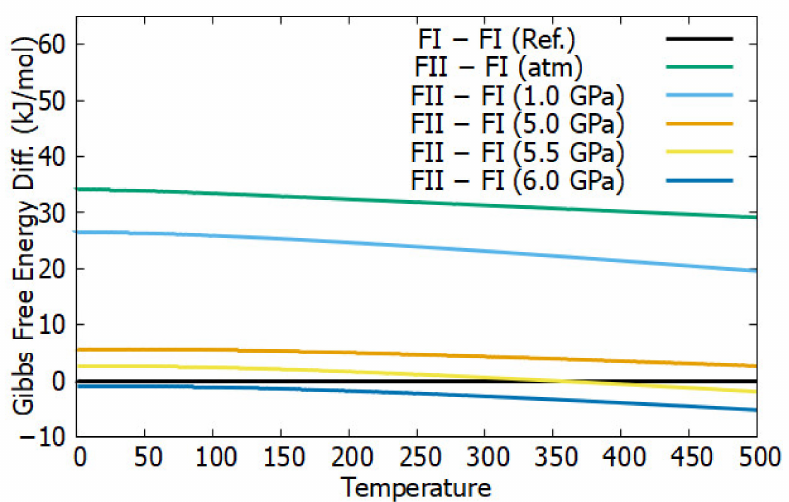
Figure 3. Gibbs free energy differences as a function of temperature for forms I and II. The green, sky-blue, orange, yellow, and blue curves represent pressures of 0.0001 GPa (atmospheric pressure), 1 GPa, 5 GPa, 5.5 GPa, and 6 GPa, respectively. The phase transformation occurs at a pressure and temperature of 5.5 GPa and ≈ 350 K,